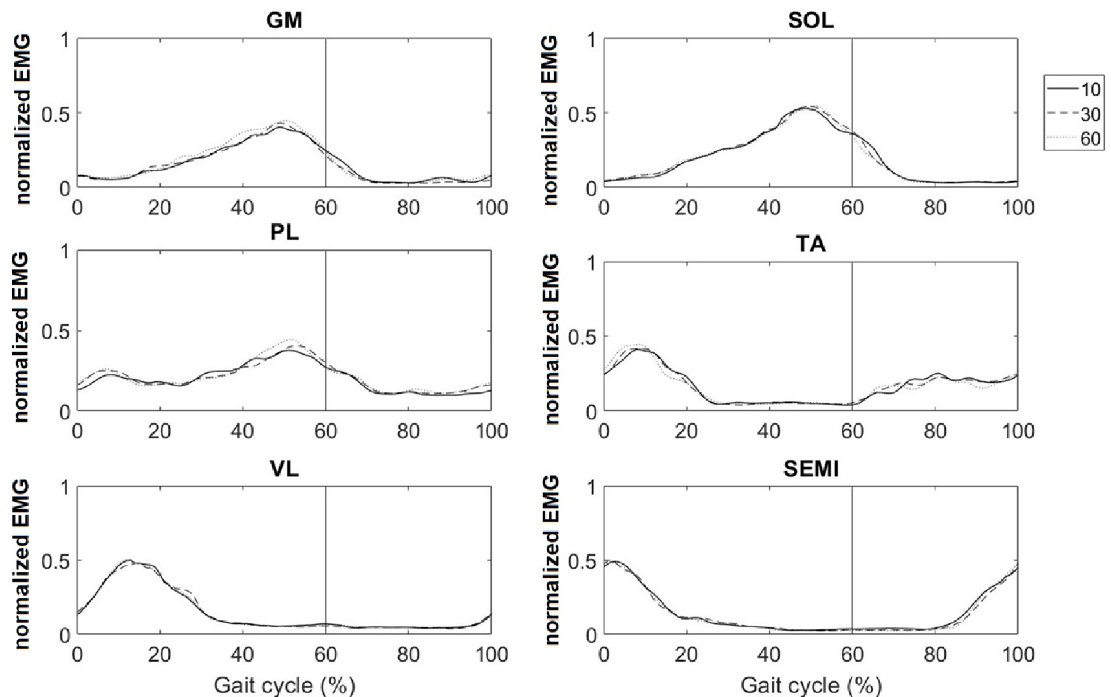
Fig 3. Averaged normalized EMG activity of gastrocnemius medialis (GM), soleus (SOL), peroneus longus (PL), tibialis anterior (TA), vastus lateralis (VL), and semitendinosus (SEMI) muscles when walking with three shoe conditions.